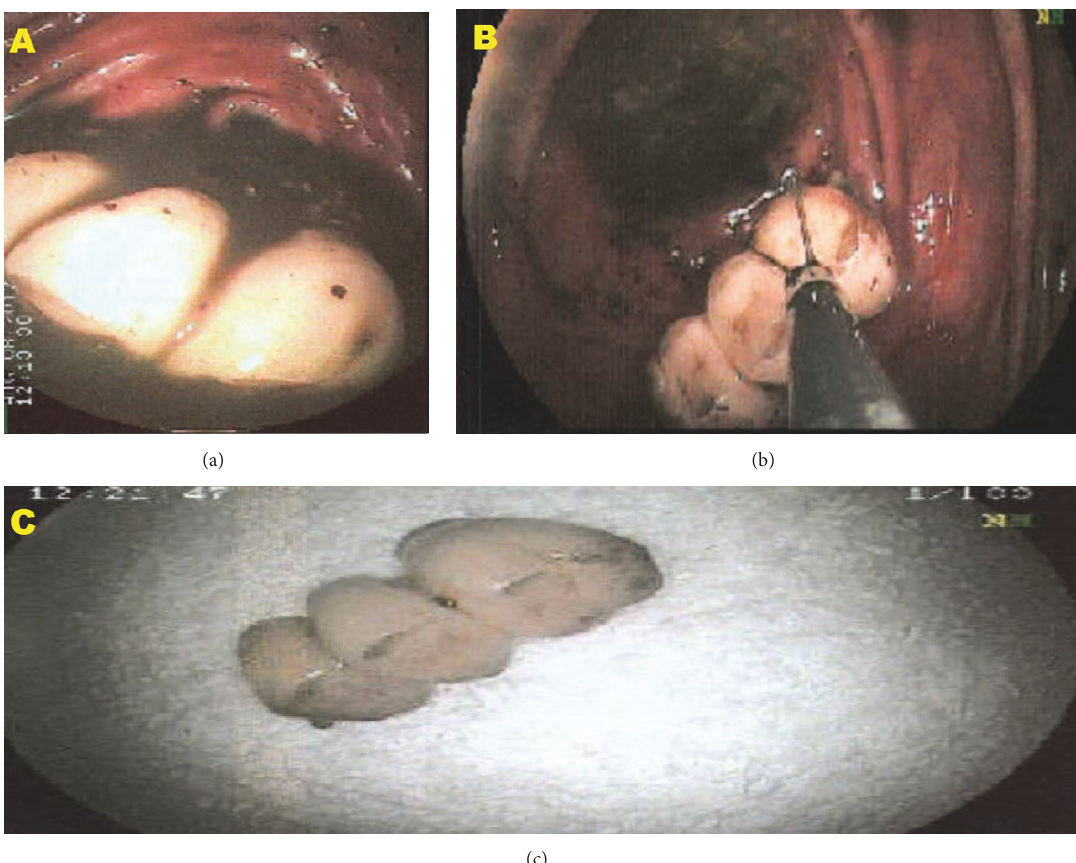
Figure 3: (a) Dental plate impacted in the cecum. (b) A colonoscopy forceps was used to grasp the end of the dental plate and to extract it. (c) The dental plate after